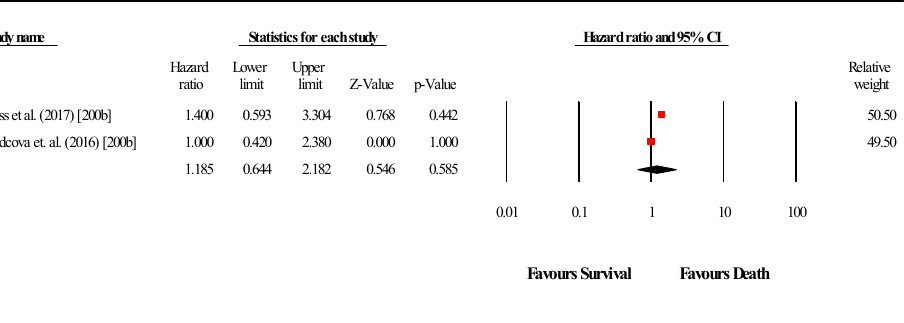
Figure 6. Forest plot for miR-155 association with OS. 3.5.4. miR-18a A total of 2 studies assessed miR-18a expression in HNC patients (Figure 7). Both studies indicated that miR-18a is upregulated in HNC. The pooled effect estimate (HR) was found to be statistically significant, with a value of 1.866 (95 % CI 1.047–3.326; p < 0.05). (I 2 = 62.964; Tau 2 = 0.652; Cochran’s Q = 2.7).